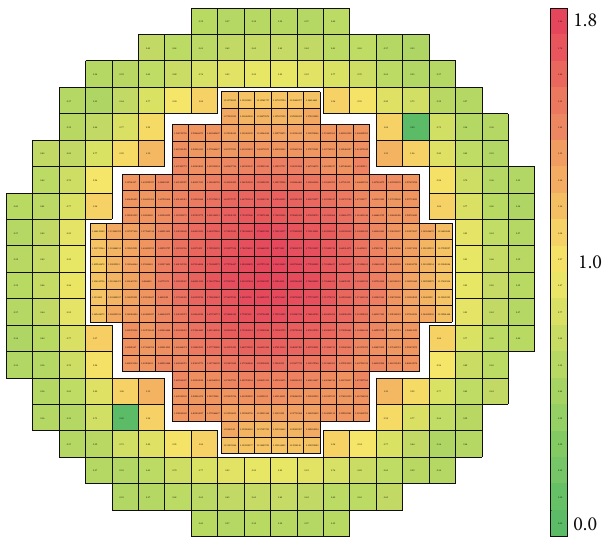
Figure 10: Serpent 2 radial power distribution (reference).